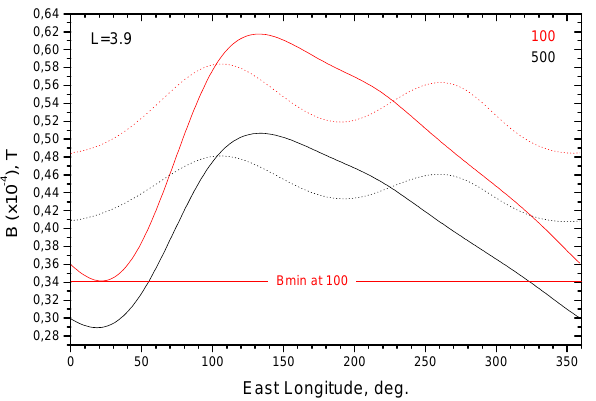
Fig. 4. Same as Fig. 2 for the magnetic shell L = 3 . 9.